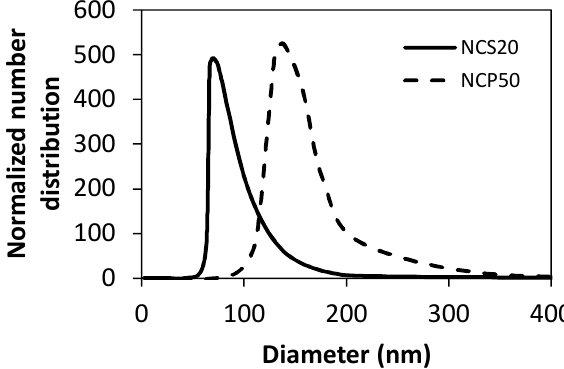
Figure 2. Number particle size distribution of NCS20 and NCP50 samples obtained through dynamic light scattering measurements at 25 °C. Nanocapsules sizes were 71 and 120 nm for NCS20 and NCP50, respectively.